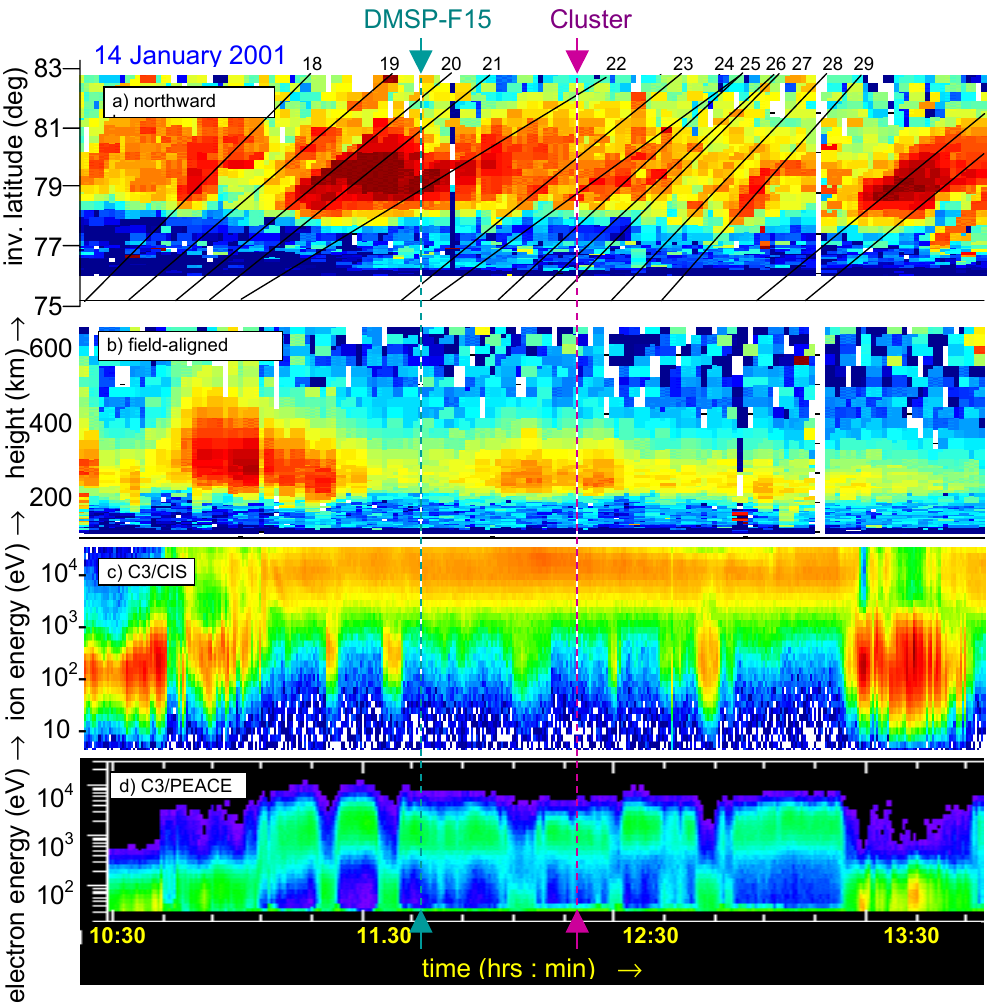
Fig. 1. Observation of transient events seen by Cluster and the EISCAT Svalbard Radar (ESR) on 14 January 2001. (a) The plasma concentrations seen in the ionosphere along the low elevation (30 ◦ ) poleward beam of the ESR, are colour-coded as a function of time and latitude. The centre of poleward-moving events are marked with a black line which is numbered in continuation of the events earlier on the same day, as studied by Lockwood et al. (2001, this issue). (b) The observations along the field-aligned ESR beam are shown as a function of time and altitude. (c) An energy-time spectrogram of differential energy flux of ions, integrated over all pitch angles, as observed by the CIS instrument on Cluster C3. (d) An energy-time spectrogram of the count rate of electrons observed by the HEEA detector of the PEACE instrument on Cluster C3 in zone 11 (electrons moving in the + Z GSE direction). The ESR and CIS data are colour-coded using the same scales as in Fig. 1 of Opgenoorth et al. (2001, this issue). The PEACE data are scaled using the same scale as in Fig. 8 of the present paper. The vertical dashed lines give the times of closest conjunction of the ESR and Cluster (mauve) and the ESR and the DMSP-F15 satellite